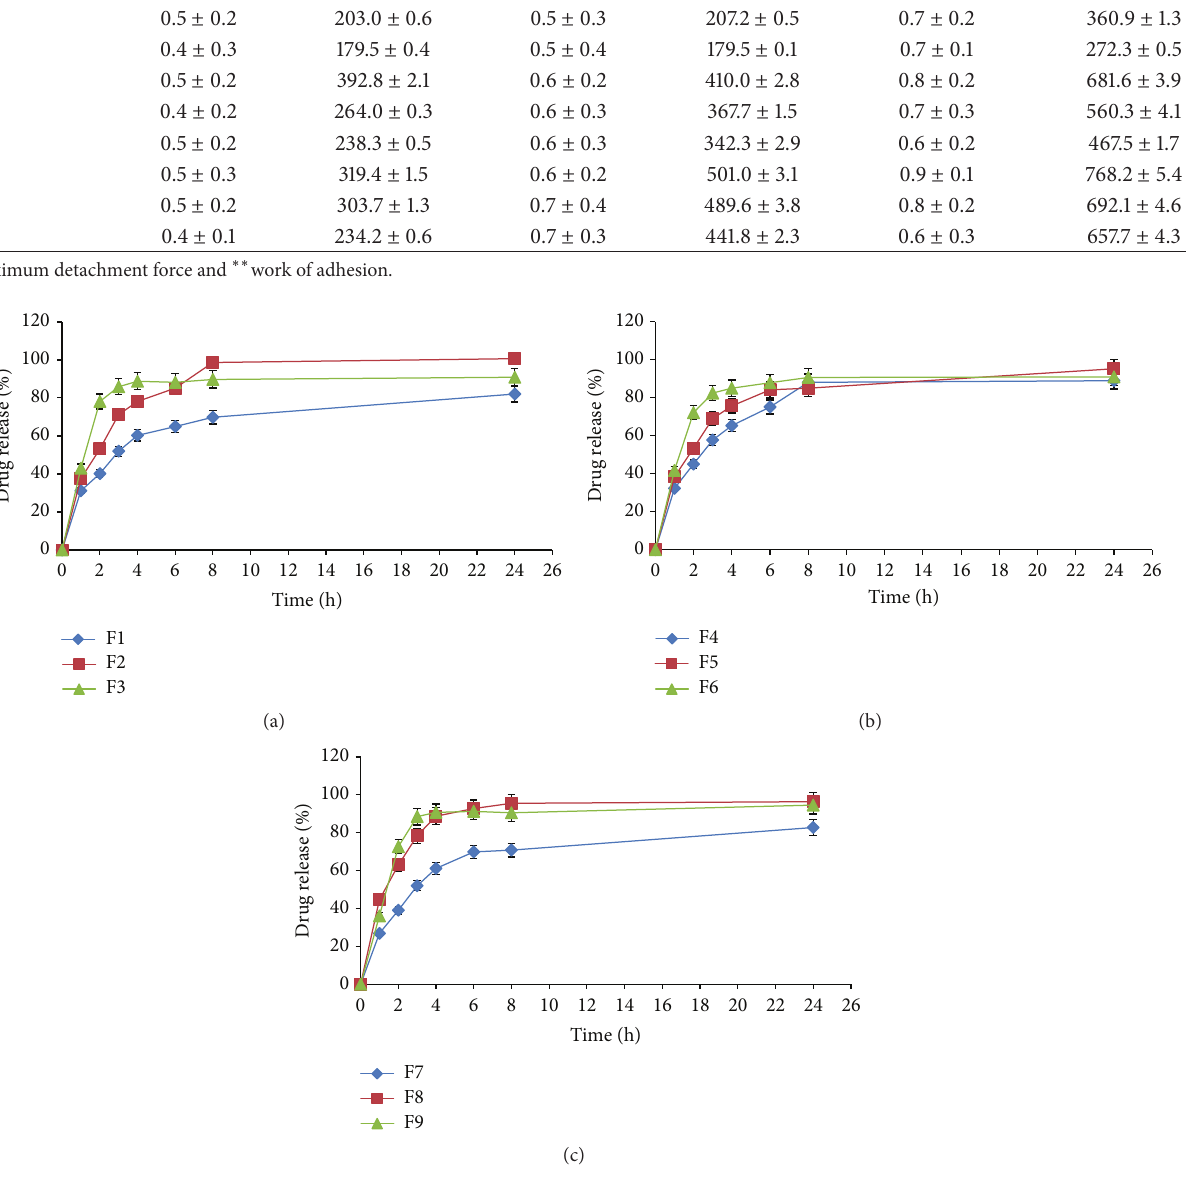
Figure 3: MF release from microspheres formulations F1–F3 (a), F4–F6 (b), and F7–F9 (c), 𝑛 = 3